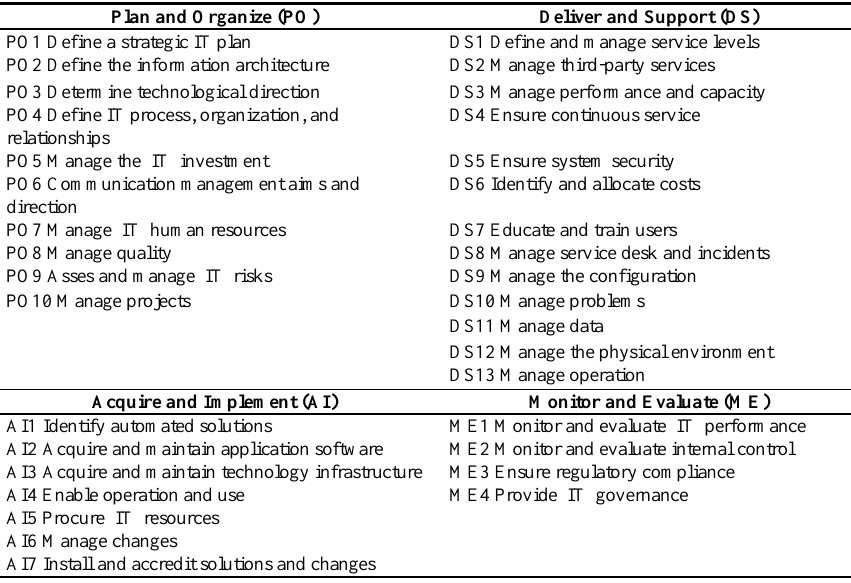
Table 2. IT processes identified by COBIT 4.1